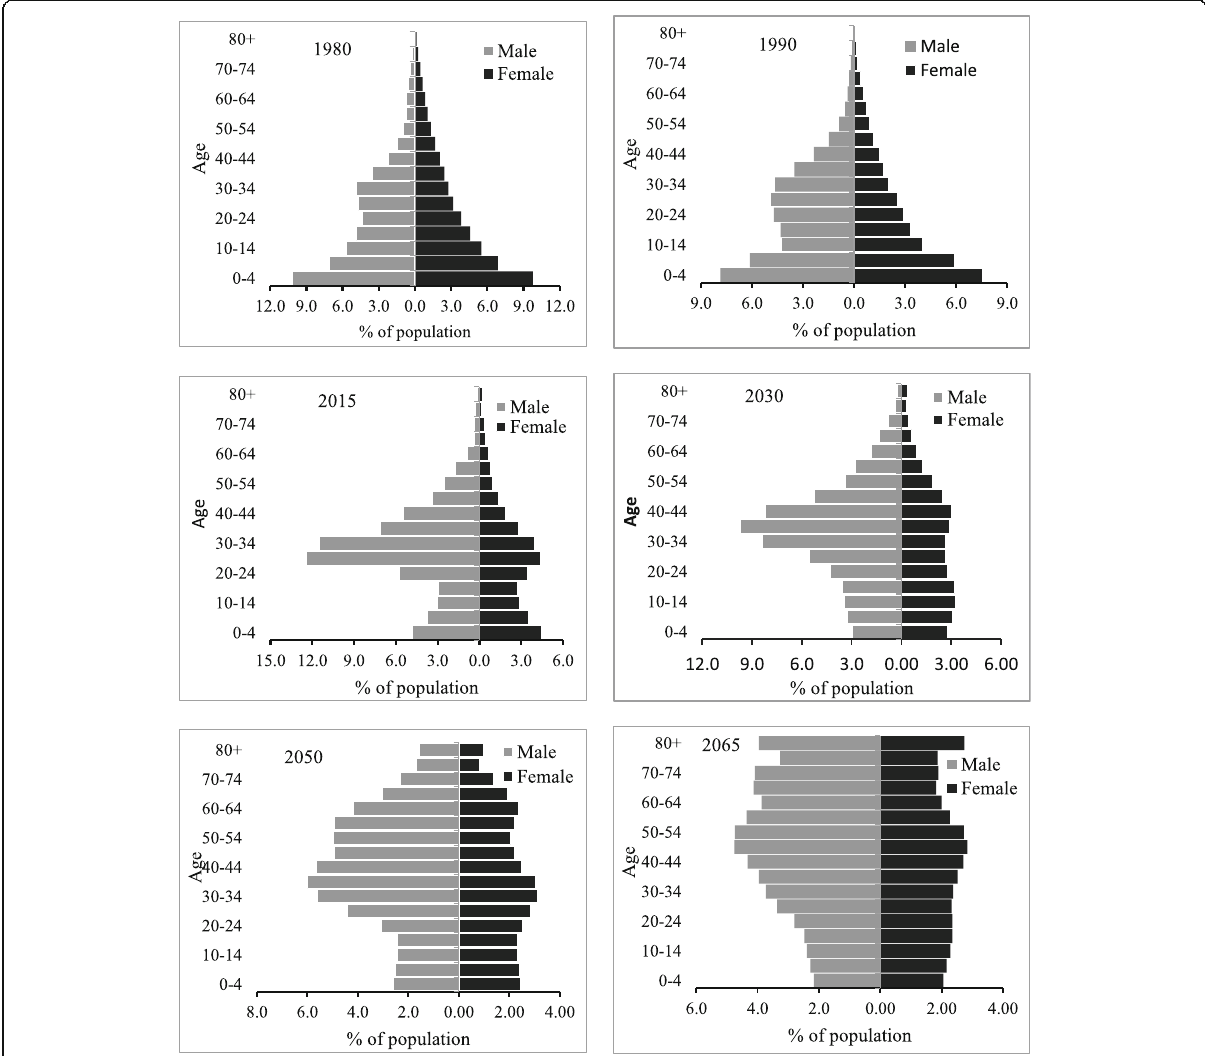
Fig. 5 Population pyramid, Oman, 1980 – 2065. Source: UN population estimates and projection